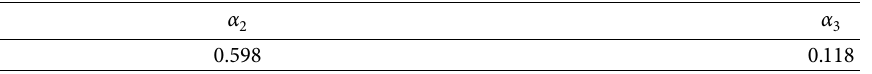
Figure 3: Type II error for different methods. Table 5: The impact of different financial